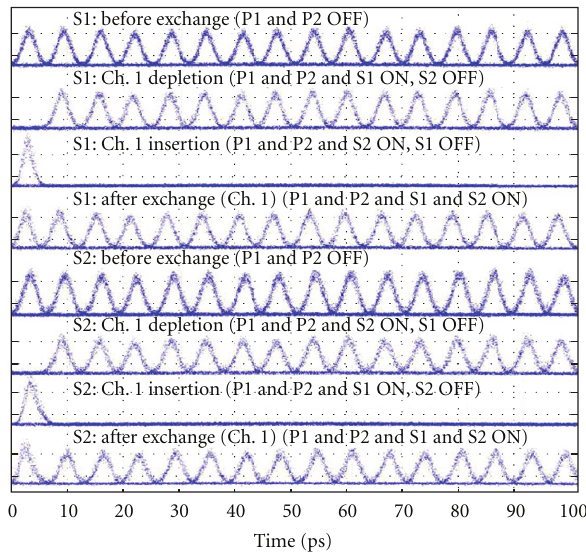
Figure 9: Measured eye diagrams for the tributary channel exchange